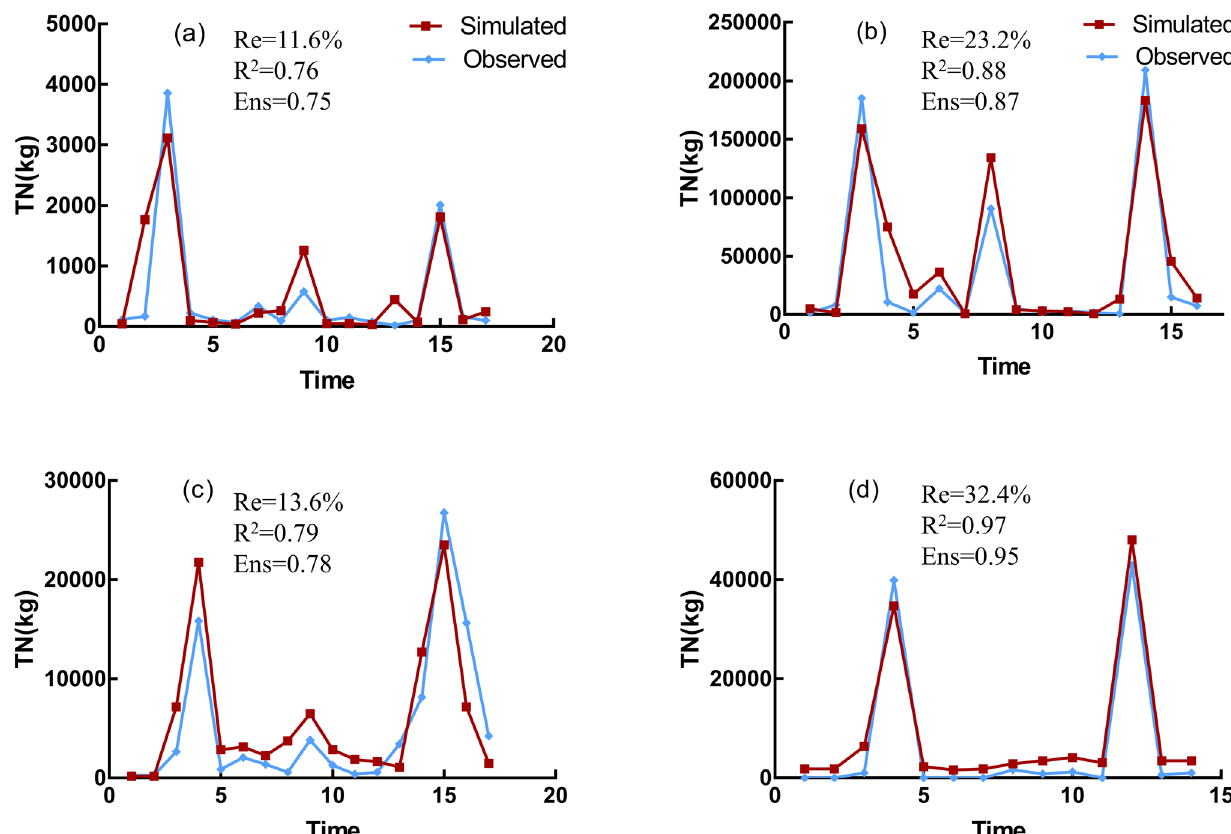
Fig. 4 Comparison of observed and simulated monthly TN during calibration period at different stations: a Dongdingjia; b Zaochao; c Houlugezhuang; d